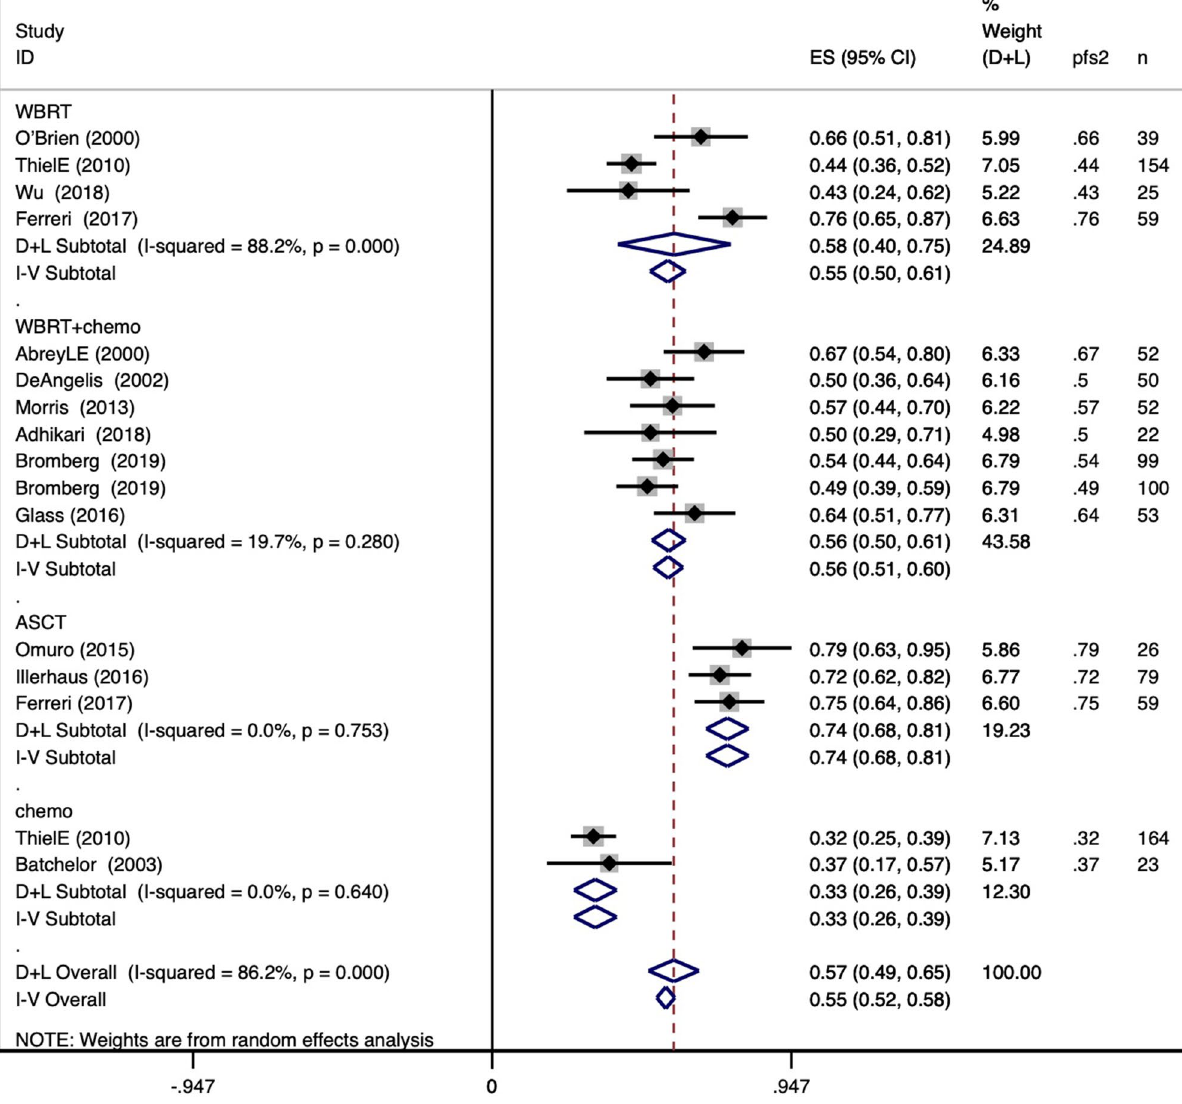
Figure 3. Forest plot of 2-year and 5-year progression-free survival within different consolidation methods. ( a ) Pooled 2-year progression-free survival for WBRT, WBRT + chemotherapy, ASCT, and chemotherapy-only consolidation; ( b ) pooled 5-year progression-free survival for the four consolidation